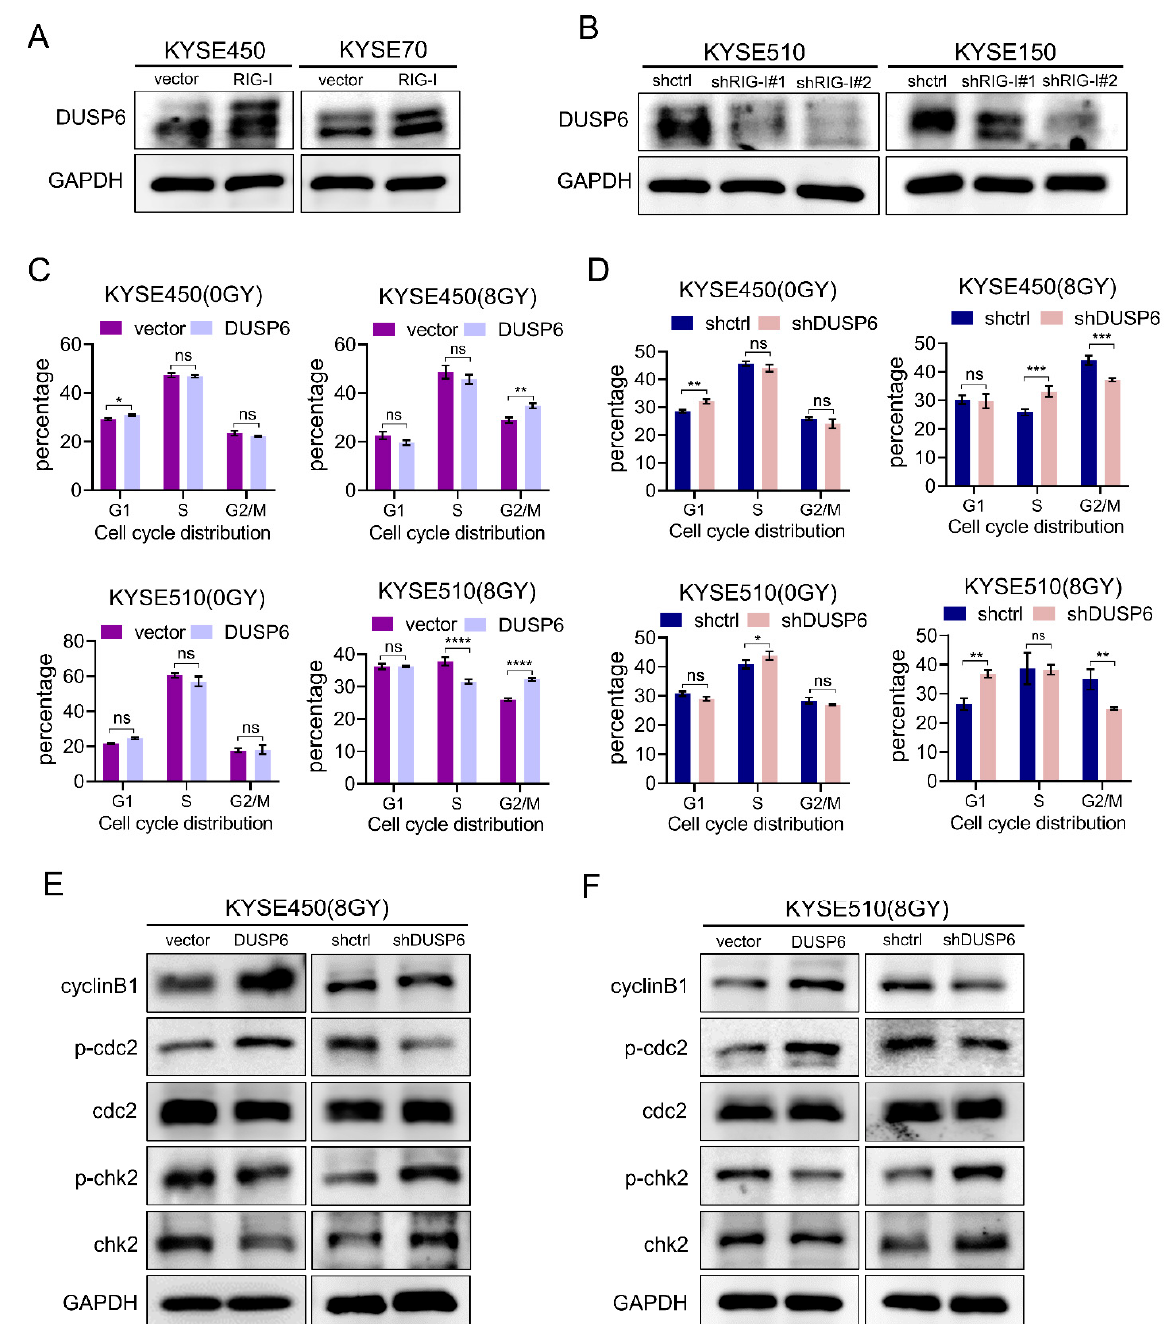
Figure 6. RIG-I targets downstream DUSP6 and causes radiation-induced G2/M arrest. Protein expression levels of DUSP6 were quantified using Western blotting ( A ) in RIG-I-overexpressing KYSE450 and KYSE70 cells ( B ) and RIG-I-lacking KYSE150 and KYSE510 cells. GAPDH was used as an internal control. Cell cycle distribution with or without irradiation was assessed in KYSE450 and KYSE510 ( C ) with overexpression of DUSP6 and ( D ) with knockdown of DUSP6 using flow cytometry. GAPDH was used as an internal control. G2/M phase DNA damage checkpoint signaling pathway-related proteins were detected in KYSE450 and KYSE510 cells ( E ) with overexpression of DUSP6 and ( F ) with knockdown of DUSP6 (using Western blotting). GAPDH was used as an internal control. Empty vector and shRNA-control were used as controls. Data are shown as mean ± SD from three independent experiments, ns: not significant, * p < 0.05, ** p < 0.01, *** p < 0.001, and **** p <